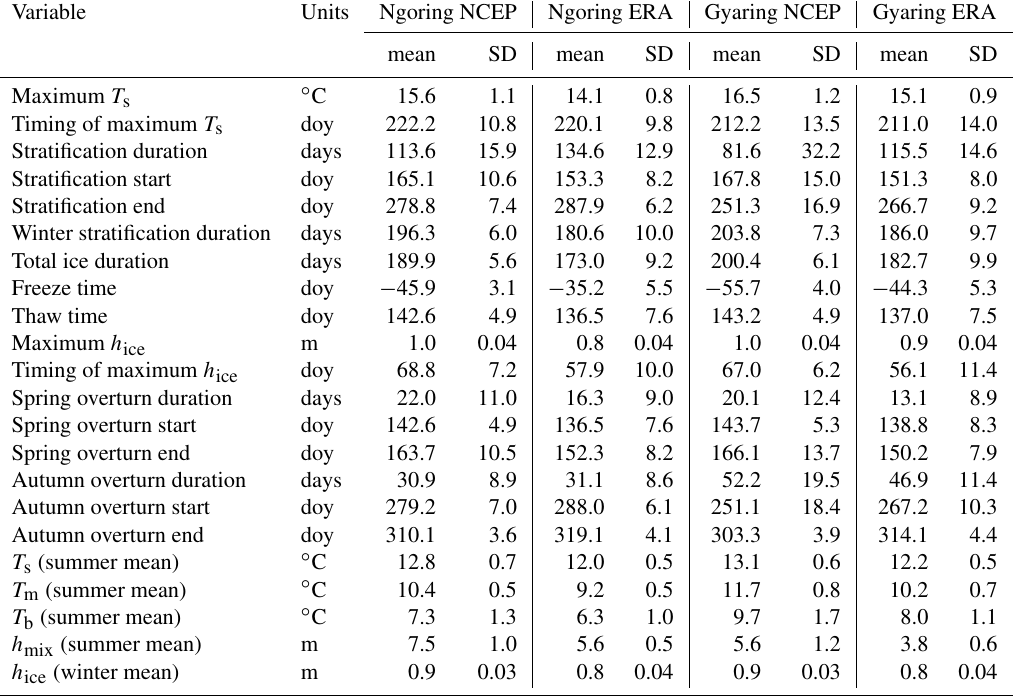
Table 2. The mean characteristics of the seasonal thermal regime in Ngoring and Gyaring forced by the NCEP/NCAR and ERA-Interim reanalysis datasets. T s , T b , and T m are temperatures at the surface, bottom, and averaged over the whole water column, respectively; h mix and h ice are the thickness of the mixed layer and the ice cover respectively; and doy is day of the